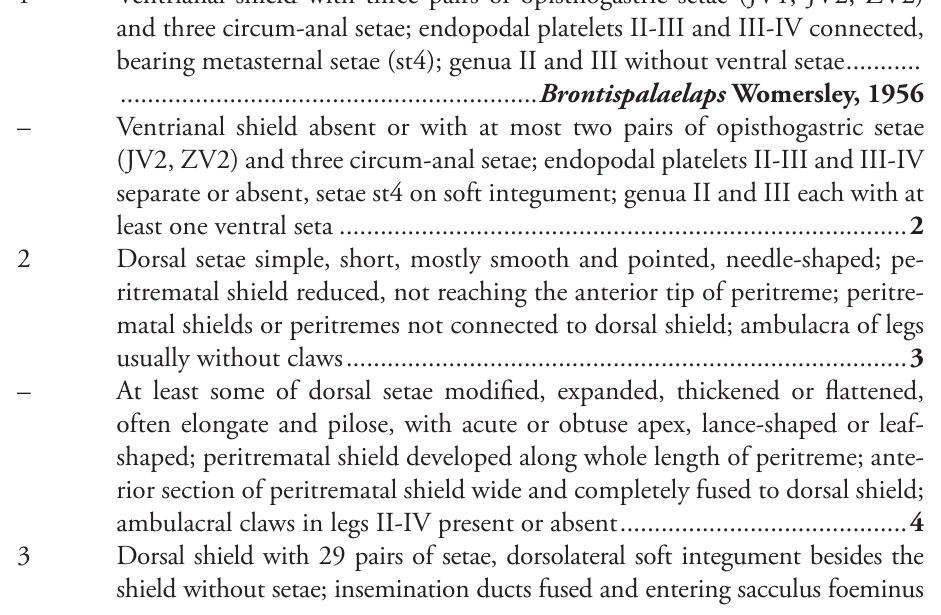
Ventrianal shield with three pairs of opisthogastric setae (JV1, JV2, ZV2) and three circum-anal setae; endopodal platelets II-III and III-IV connected, bearing metasternal setae (st4); genua II and III without ventral setae ........... – Ventrianal shield absent or with at most two pairs of opisthogastric setae (JV2, ZV2) and three circum-anal setae; endopodal platelets II-III and III-IV separate or absent, setae st4 on soft integument; genua II and III each with at least one ventral seta ................................................................................... 2 Dorsal setae simple, short, mostly smooth and pointed, needle-shaped; pe- ritrematal shield reduced, not reaching the anterior tip of peritreme; peritre- matal shields or peritremes not connected to dorsal shield; ambulacra of legs – At least some of dorsal setae modified, expanded, thickened or flattened, often elongate and pilose, with acute or obtuse apex, lance-shaped or leaf- shaped; peritrematal shield developed along whole length of peritreme; ante- rior section of peritrematal shield wide and completely fused to dorsal shield; Dorsal shield with 29 pairs of setae, dorsolateral soft integument besides the shield without setae; insemination ducts fused and entering sacculus